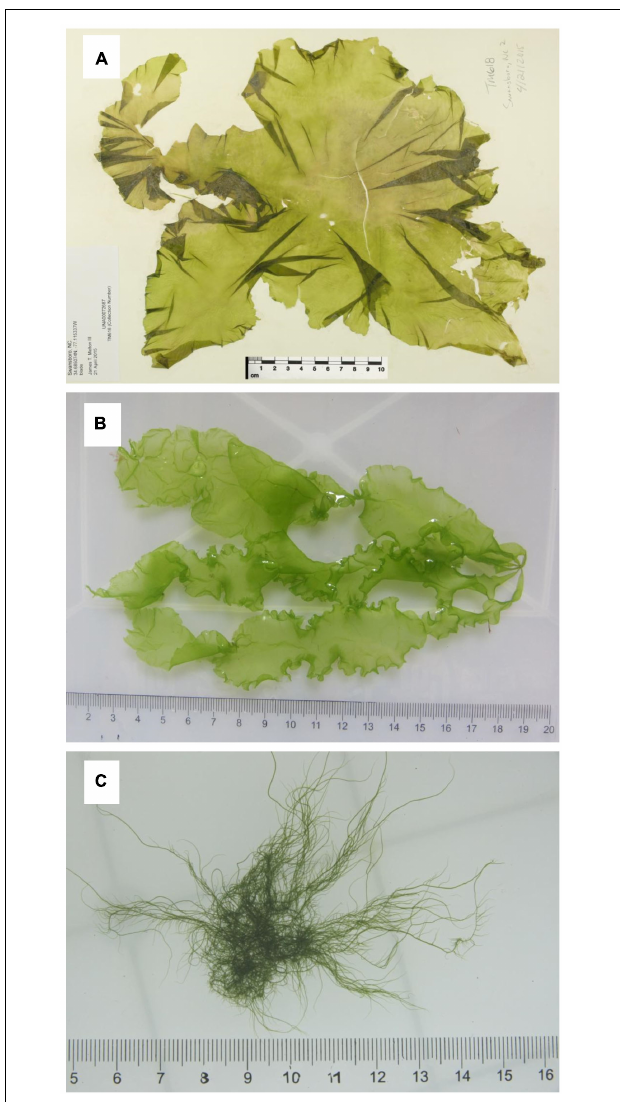
FIGURE 1 | Three morphotypes of Ulva compressa collected from China and USA: (A) Uco1 with foliated, distromatic blade, (B) Uco2 with ribbon, distromatic blade and monostromatic, tubular margins, and (C) Uco3 with filamentous, tubular blade, and dense branches.